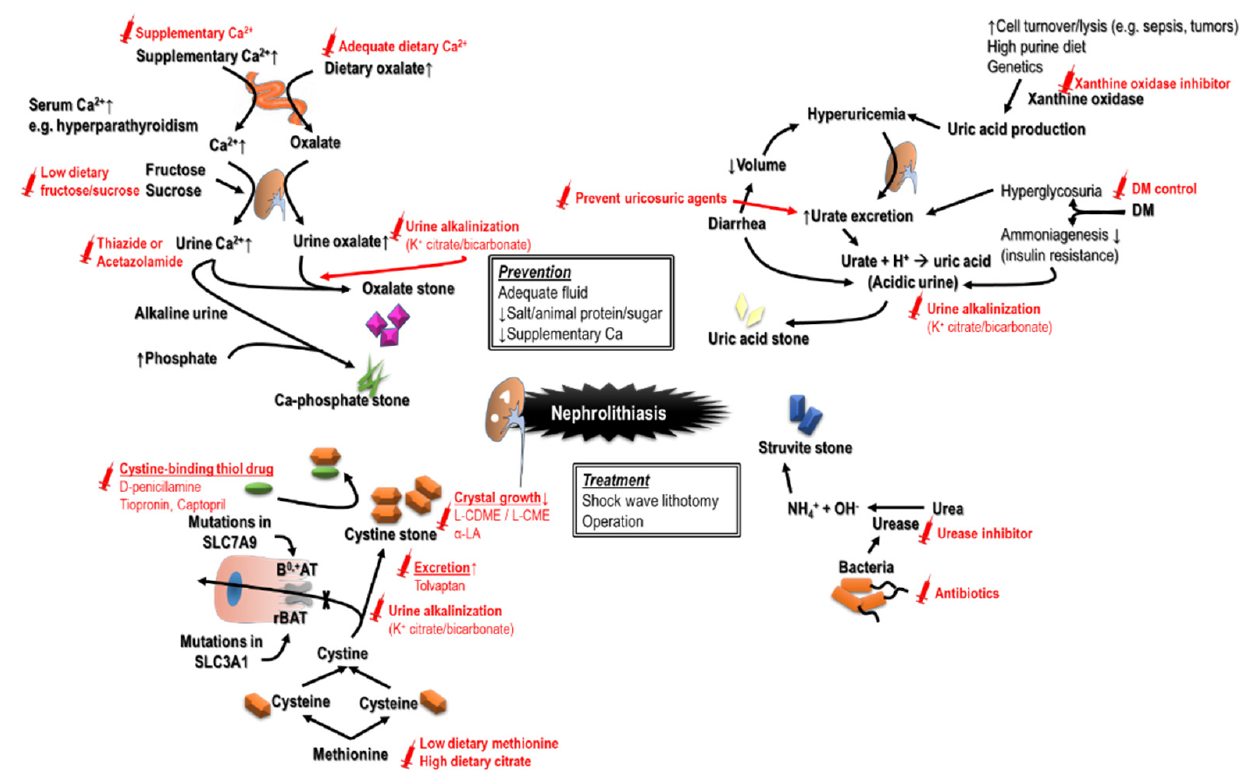
Figure 5. Different causes of nephrolithiasis and urothithiasis with the recommended management strategies to avoid recurrence.